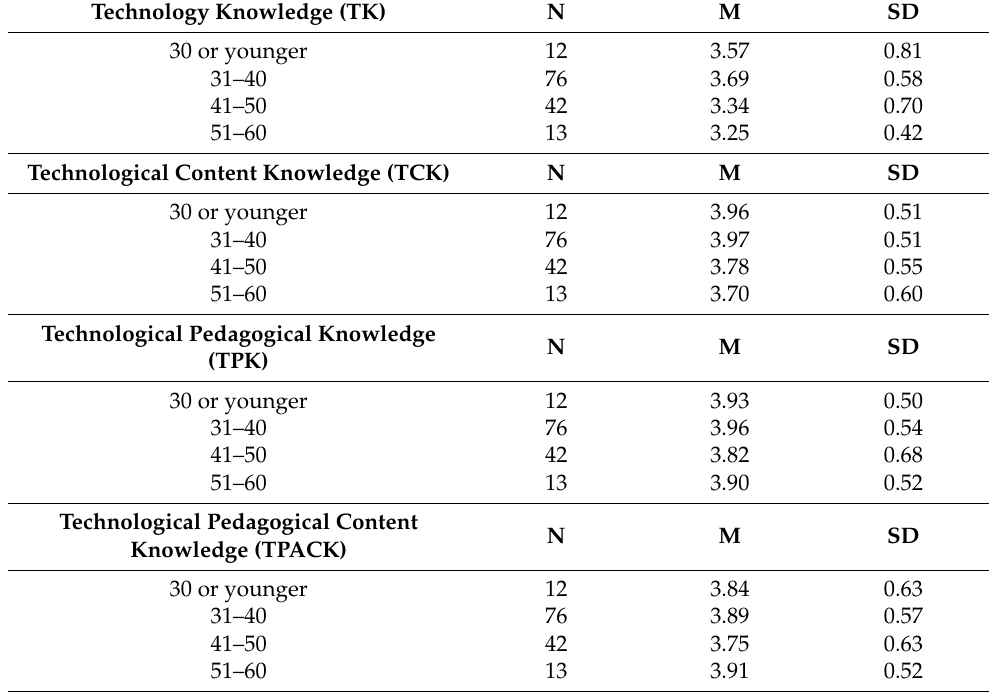
Table 5. t -test Analysis by the age of Respondents on TK, TCK, TPK, and TPACK constructs (n =